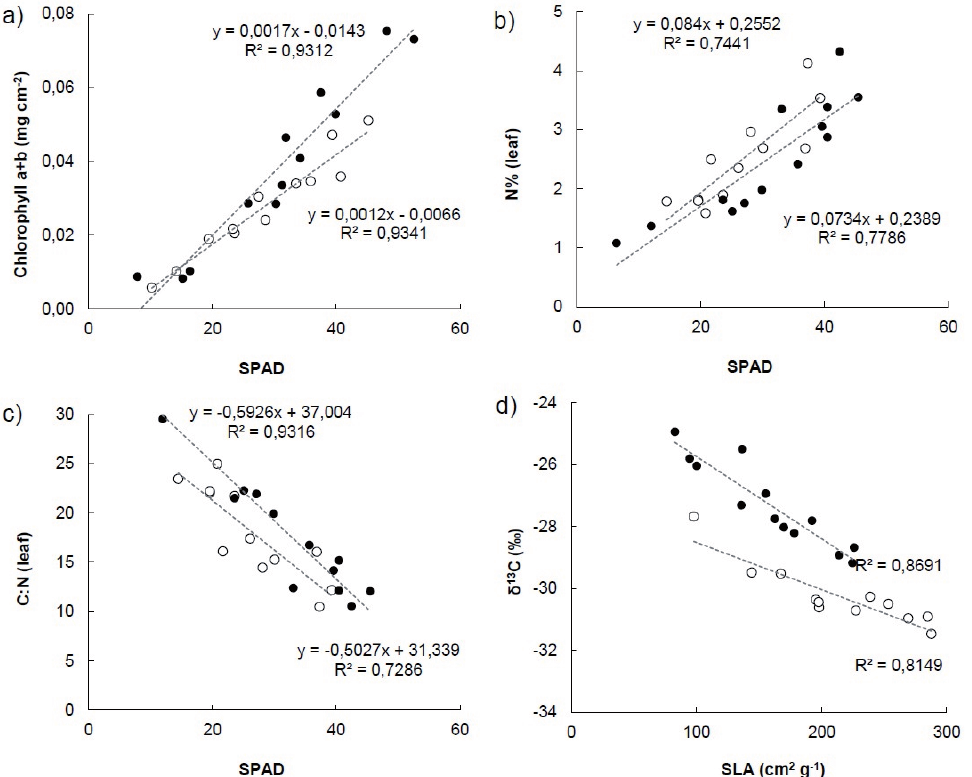
Fig. 1: Relationships between SPAD and leaf chlorophyll concentrations (a), leaf N concentration (b) and C:N (c) and relationships between specific leaf area and δ 13 C signatures (d) in S. hermaphrodita ( ○ ) and S. perfoliatum ( ●